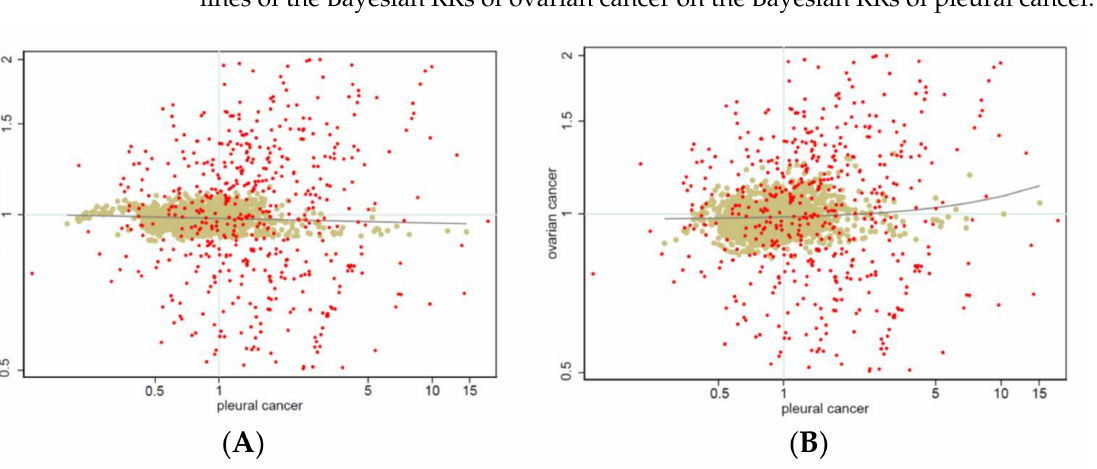
Figure 3. Log–log scatter plot of raw (red dots) and Bayesian smoothed standardized mortality ratios (SMR) (khaki dots) for ovarian cancer (y-axis) and pleural cancer (x-axis). ( A ) Estimates from M1; ( B ) estimates from M7 (see text). Linear regression lines fitted on Bayesian smoothed rates. Lombardy Region, 2000–2018. Absolute